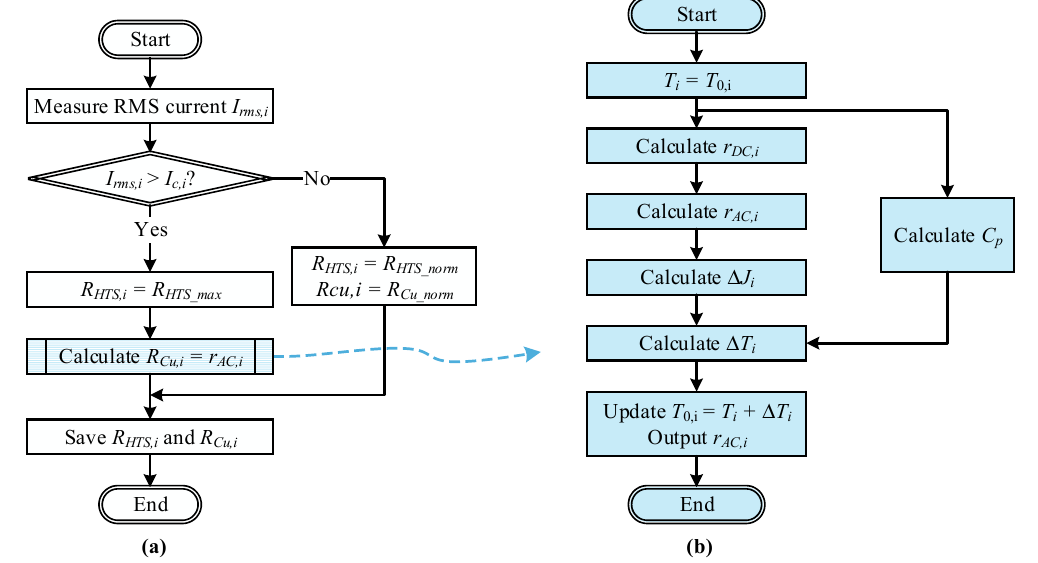
Figure 4. Calculation of the resistance and temperature of the Cu-former layer i in each simulation step: ( a ) calculation process of the proposed model; and ( b ) subprocess calculates R Cu